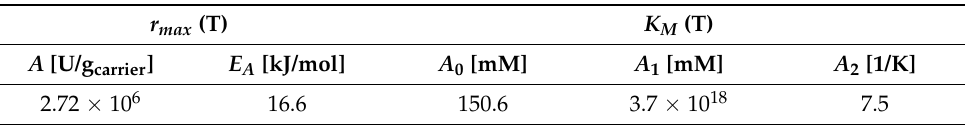
Table 4. Parameters of Equations (3) and (4) modelling the temperature dependence of the Michaelis–Menten (MM) coefficients given in Table 3.